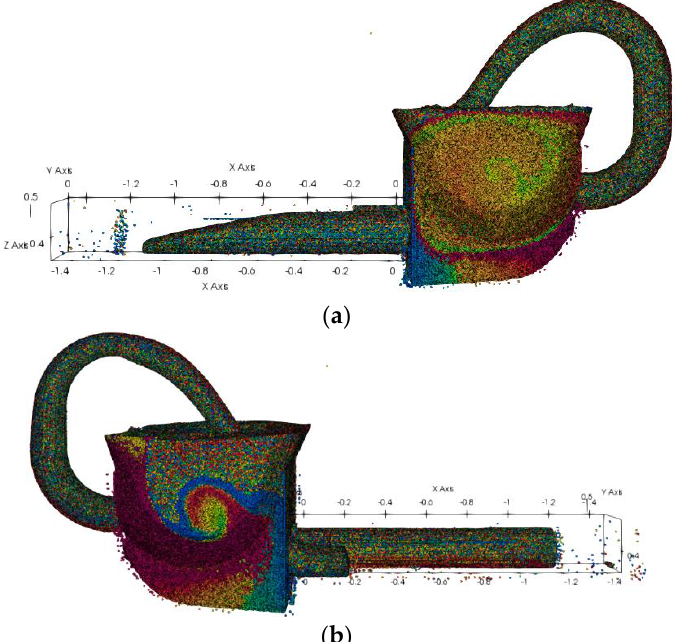
Figure 17. Concrete flow during pumping suction. ( a ) Flow state and velocity sampling; ( b ) Suction efficiency.